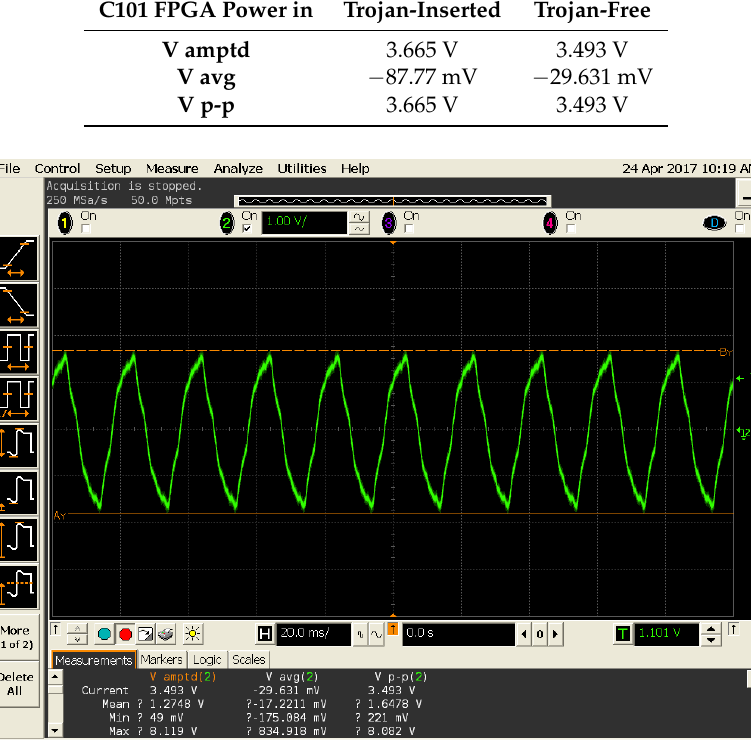
Figure 12. Trojan-free readings of the C101 Capacitor Charging and